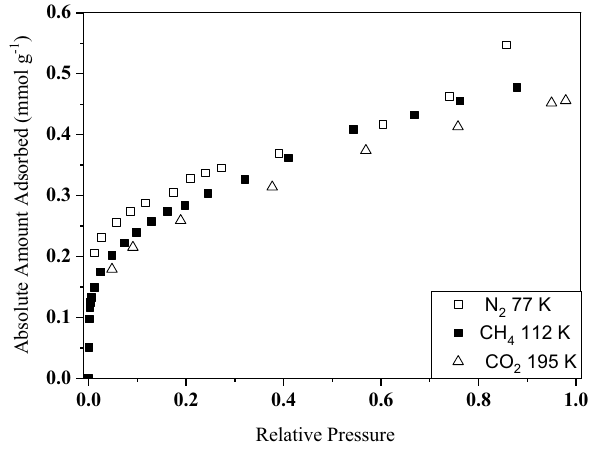
(112 K), N (77 K) 4 2